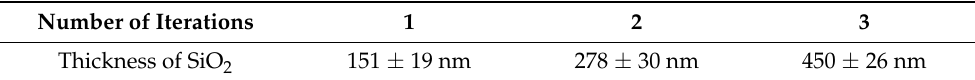
Table 1. SiO 2 shell thicknesses vs. the number of iterations of SiO 2 deposition on iron particles.